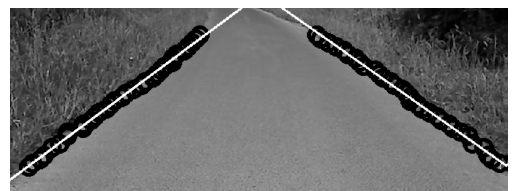
Figure 9. Black circles are used to compute the metrics.